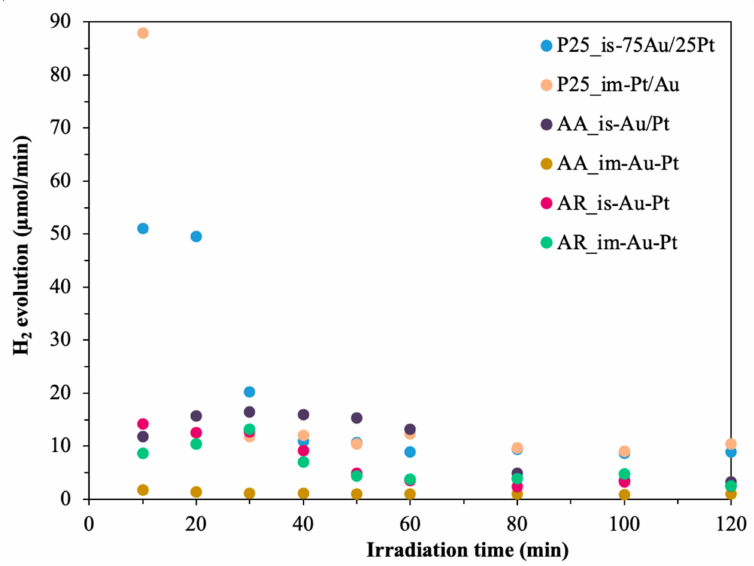
Figure 12. Time-resolved hydrogen production rates of the composites, which produced the most H 2 —the best value of all the samples is